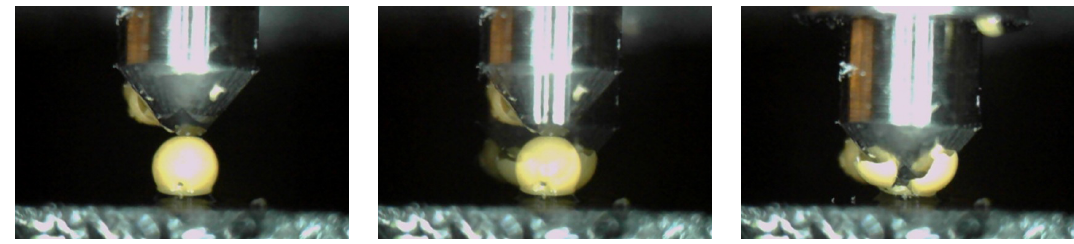
Figure 2. Dynamic process of a microcapsule under the rupturing-force